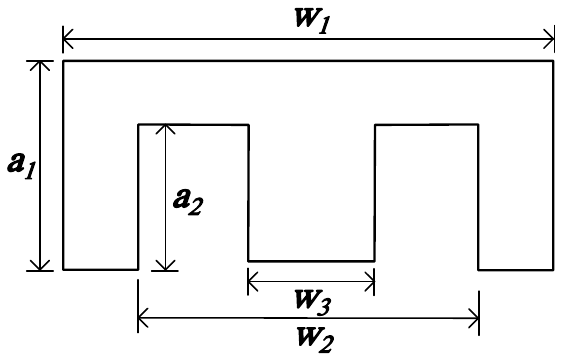
Figure 7. Reluctance model of VI.